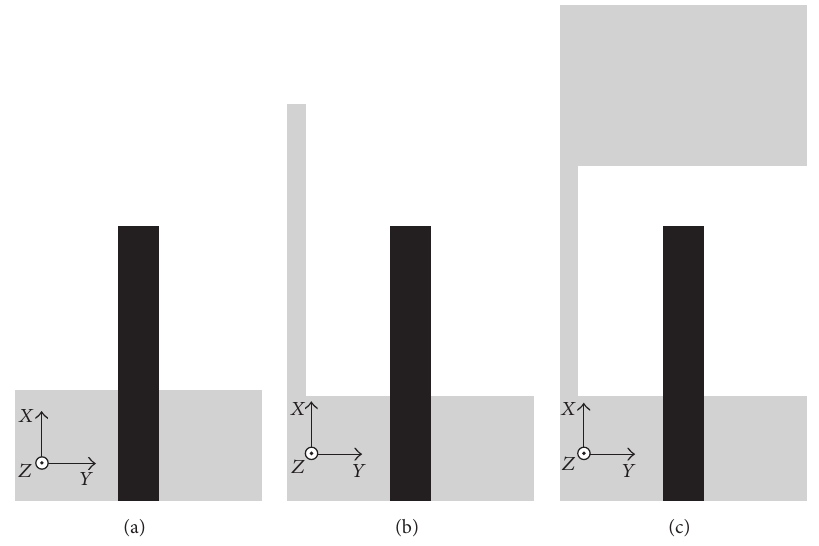
Figure2:Evolutionoftheproposedantennasdesign.(a)Conventionalstripmonopole(AntennaA).(b)Themonopolewithashortedground plane parasitic resonator (Antenna B). (c) The proposed antenna (Antenna C).